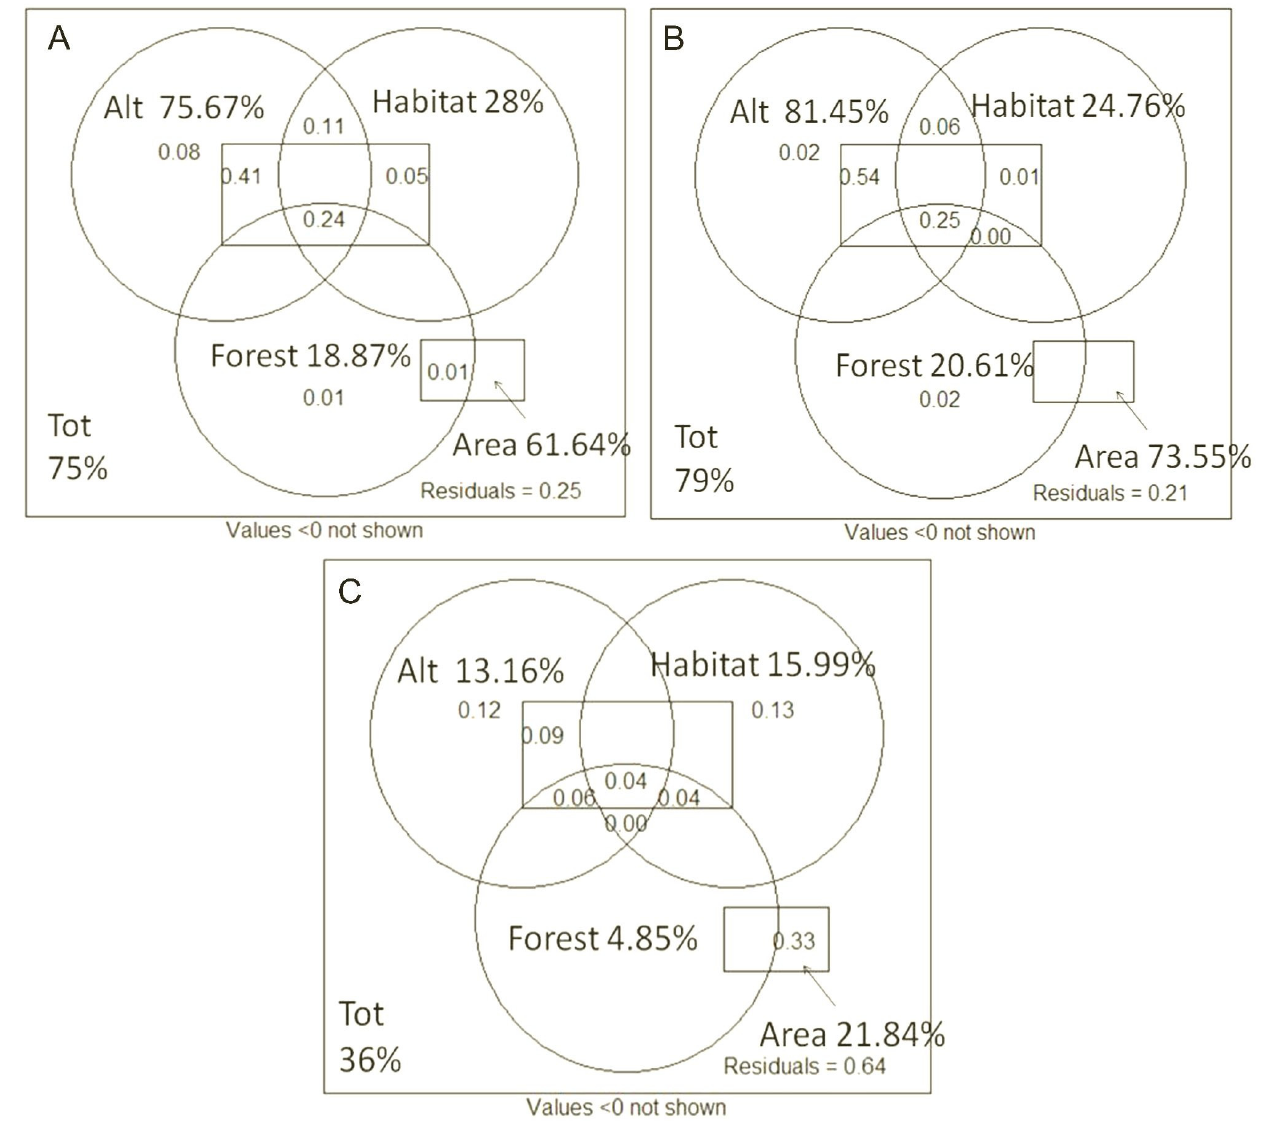
Figure 7. Percentage of variability explained by the four indicated components. Forest = primary or secondary forest, Alt = elevation levels, Area = Otonga or Otongachi, Habitat = other environmental variables. Models built on data of ( A ) species richness per plot; ( B ) number of rare morphospecies of each individual plot; ( C ) percentage of rare morphospecies of each individual plot.